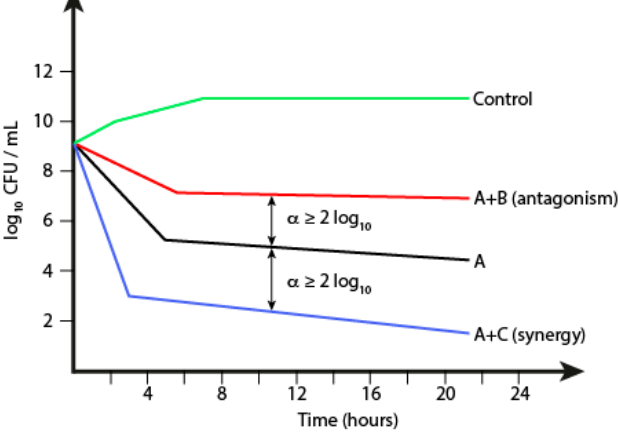
Figure 3. Schematic representation of a time-kill kinetics experiment.